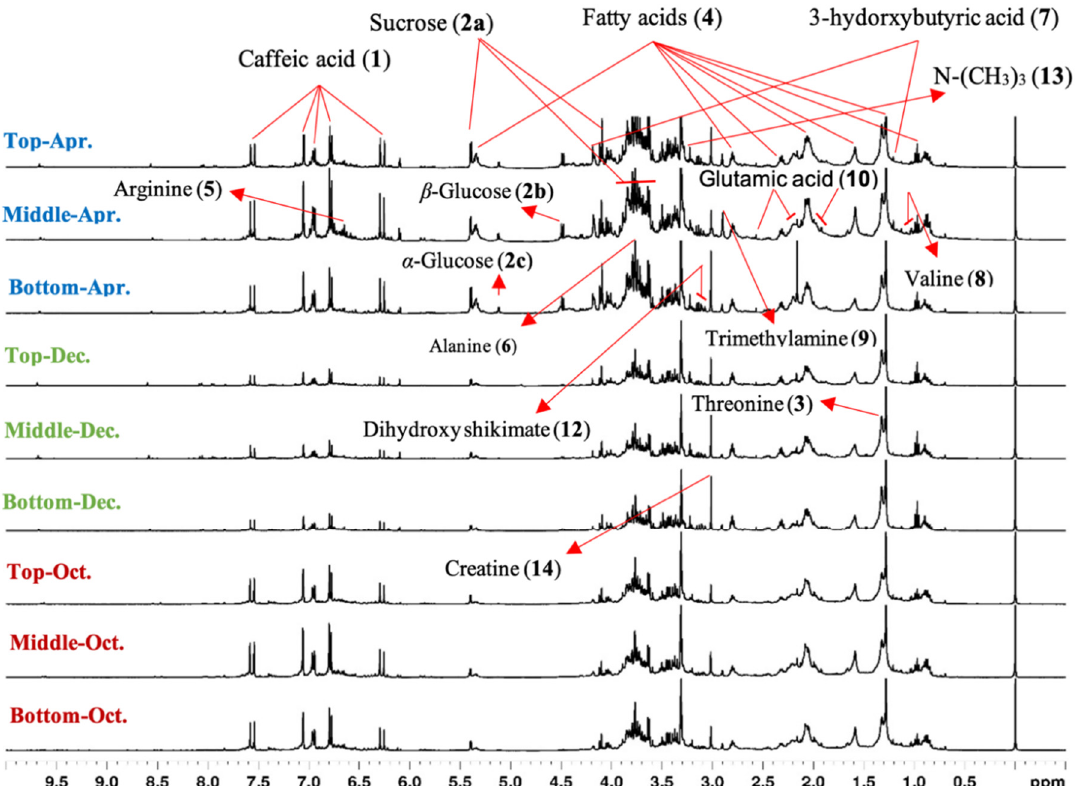
Figure 10. Stacked outline and visual assessment of the 1 H HR-MAS NMR spectra recorded from the leaves of Berberis laurina associated to different times (October 2018 to April 2019).